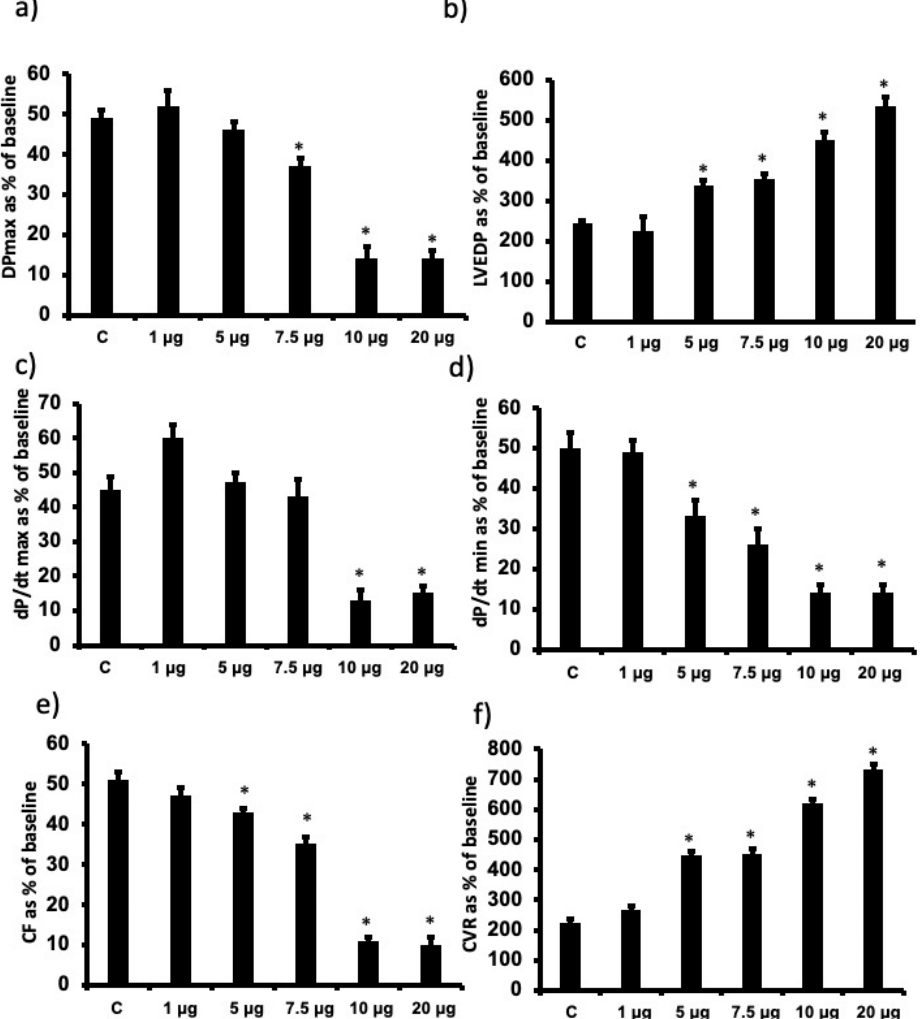
Figure 2. Dose-dependent recovery of cardiac function parameters following I/R upon acute administration of different doses of G7 cationic PAMAM (1.0 through 20 µg/mL). Percent recovery of cardiac function data ( a – f ) following I/R for left ventricle function (DPmax ( a ) and LVEDP ( b )), contractility indices (+dP/dt ( c ) and − dP/dt ( d ) and coronary vascular dynamics (CF ( e ) and CVR ( f )) are shown. The data were computed after 30 min reperfusion and expressed as the mean ± SEM. DPmax: maximum developed pressure; LVEDP: left ventricular end-diastolic pressure; CF: coronary flow; CVR: coronary vascular resistance. Control hearts, C = I/R alone. N = 8. Mean ± SEM. Asterix (*) indicates significant difference ( p < 0.05) from